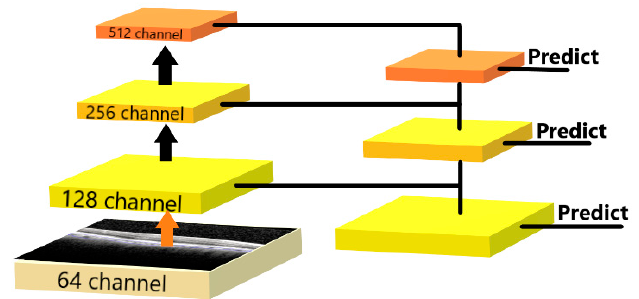
Figure 4. The FPN architecture: FPN will select the features of all layers to process and then combine the channel of features as the final result.